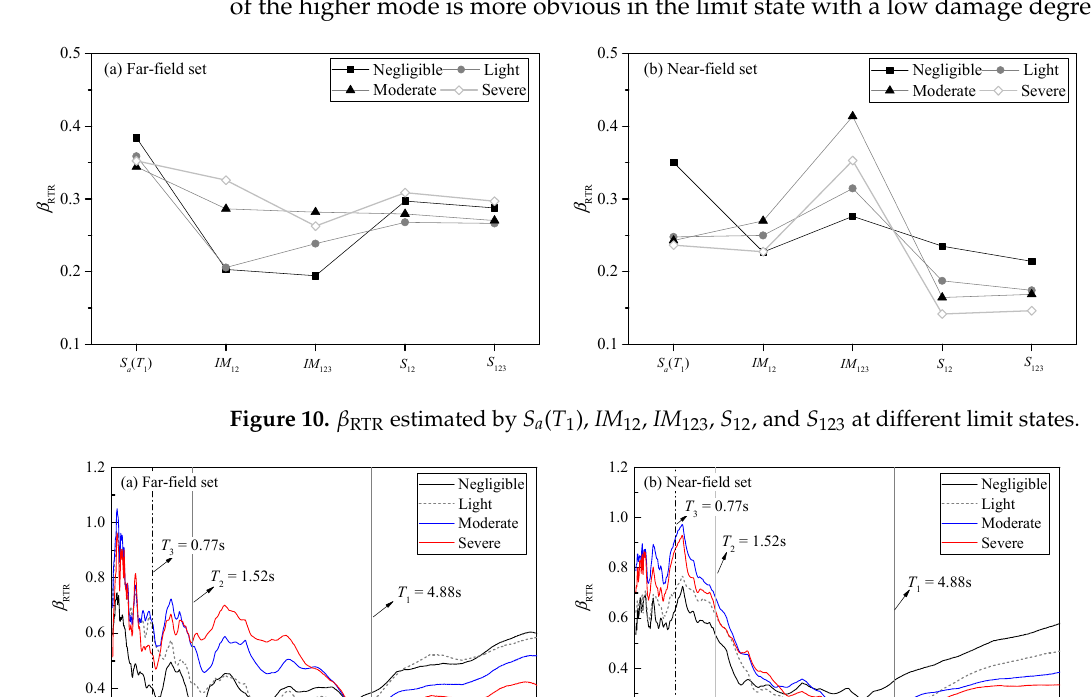
Figure 10. β RTR estimated by S a ( T 1 ), IM 12 , IM 123 , S 12 , and S 123 at different limit states.